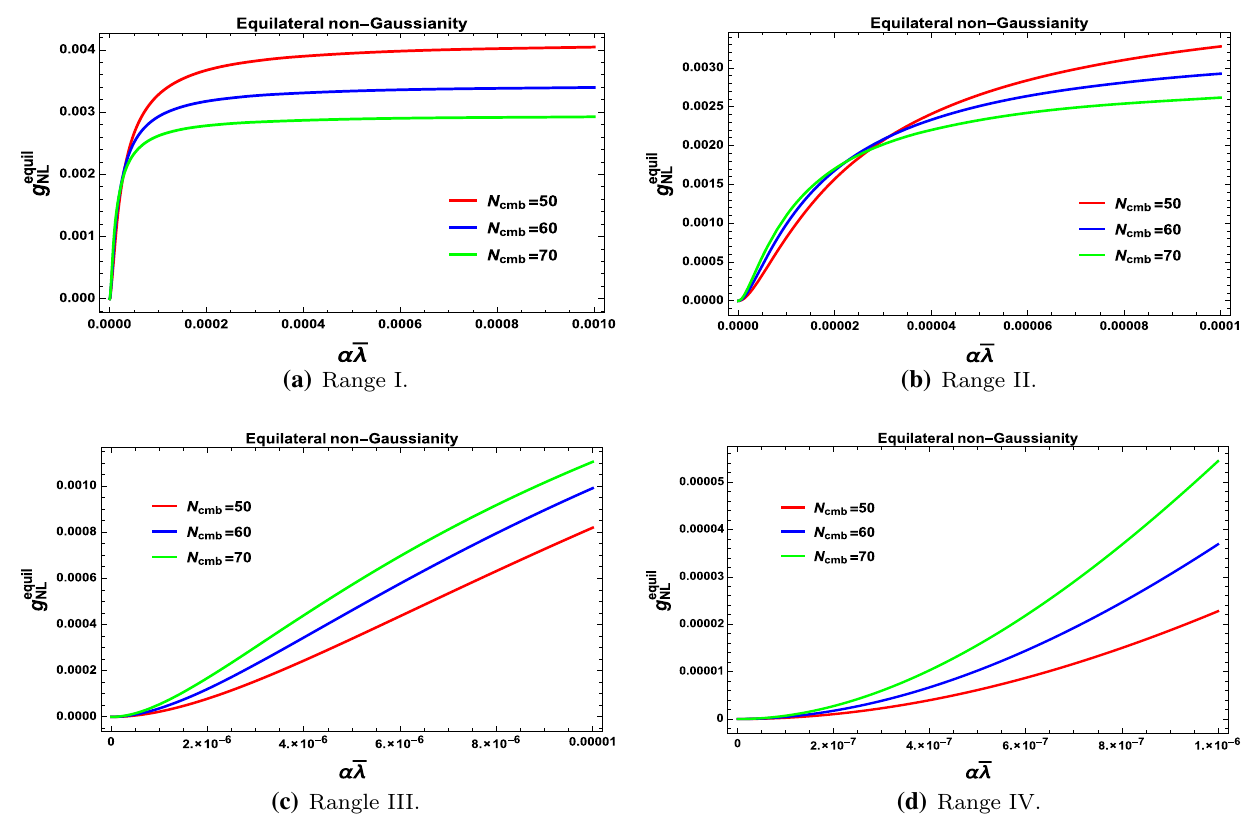
Fig. 24 Representative diagram for equilateral non-Gaussian three point amplitude vs. product of the parameters α ¯ λ in four different regions for = 50 ( red ), N = 60 ( blue ) and N = 70 ( green N cmb cmb cmb